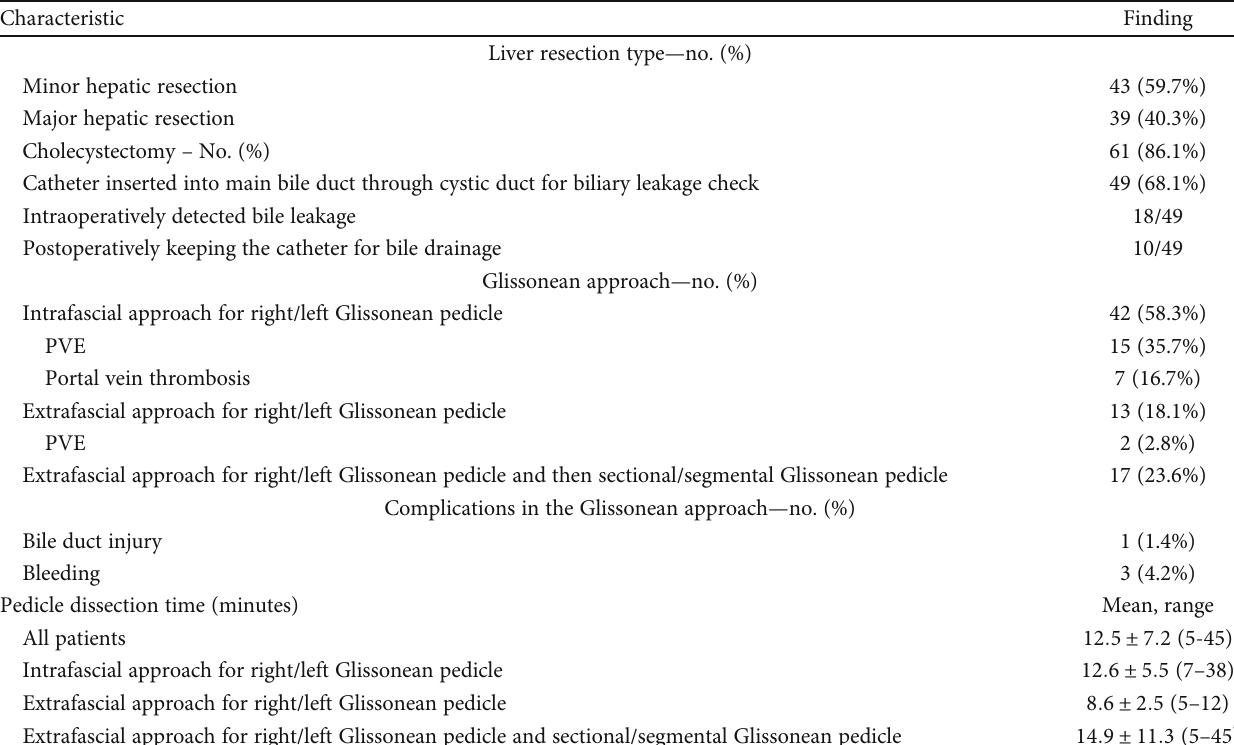
Table 2: Perioperative